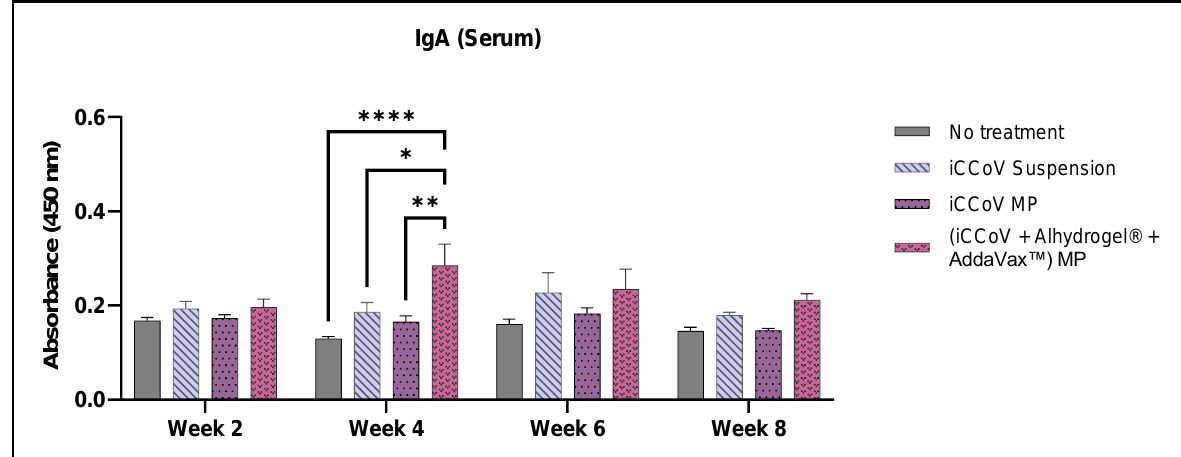
Figure 10. Assessment of serum IgA antibody levels in mice . (Absorbance at 450 nm). Responses obtained are compared to the naïve group (No treatment control) and the iCCoV suspension group. Data are expressed as mean ± SEM, n = 4 mice, Two- way ANOVA, Post hoc Tukey’s multiple comparisons test. * p ≤ 0.05, ** p ≤ 0.01, **** p ≤ 0.0001.